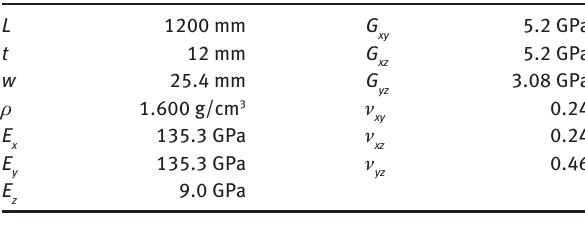
Table 1: Beam properties.